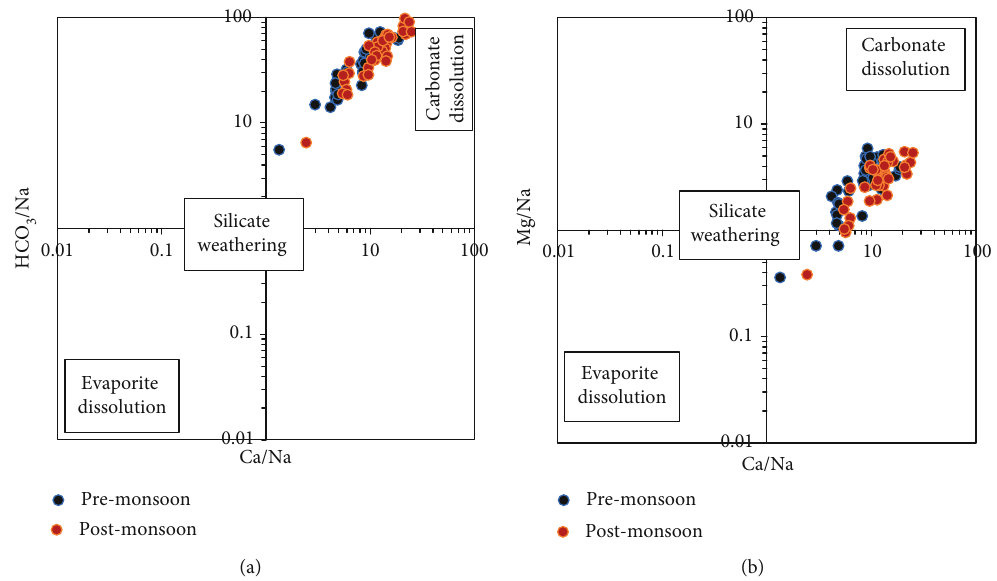
Figure 10: Bivariate plot (a) Ca/Na vs. HCO /Na, and (b) Ca/Na vs. Mg/Na to classify the mineral weathering of groundwater in the study 3 area. The boxes characterize the ranges of estimated compositions of the three main source end members (evaporate dissolution, silicate weathering, and carbonate dissolution) without any